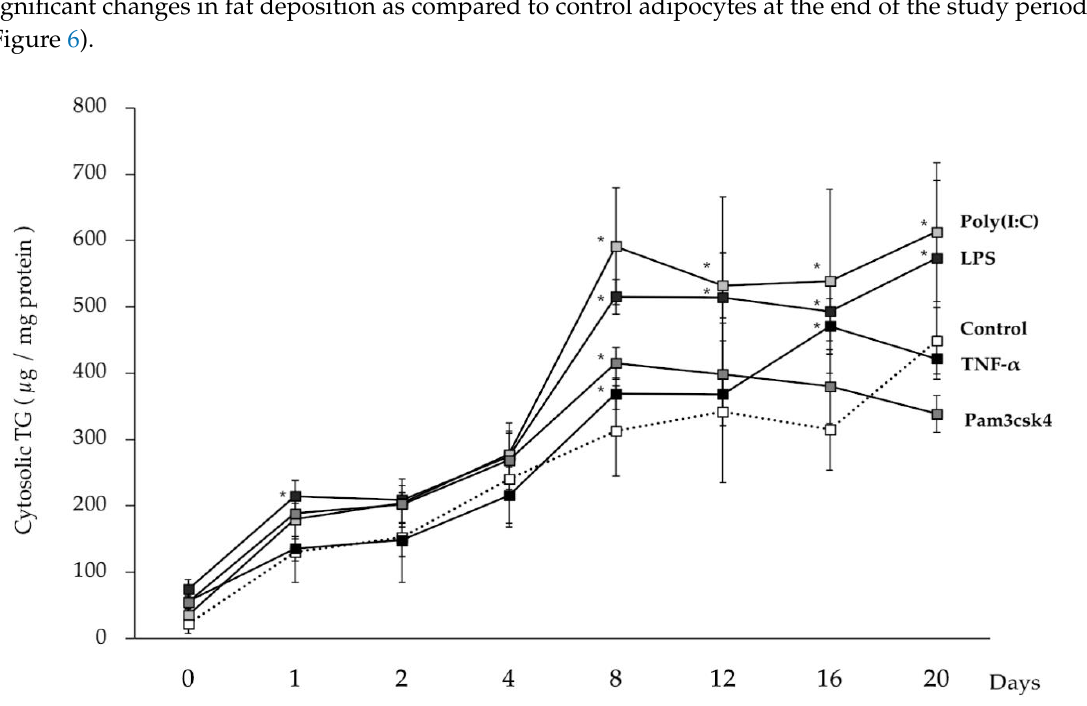
Figure 6. Regulation of fat accumulation in adipocytes by the stimulation of immune receptors. Adipocytes were stimulated either by TNF- α (2.5 ng / mL) or Pam3csk4 (10 ng / mL) or poly(I:C) (0.1 µ g / mL) or LPS (0.1 µ g / mL) for 12 h and kept for 20 days with regular changing culture media. Pam3CSK4, poly(I:C), and LPS represent the ligands for TLR2, TLR3 and TLR4, respectively. Data shown are the average ± SD of 3 independent experiments performed in triplicates. The asterisk (*) indicated the statistical difference between each treated group cells and the untreated control of corresponding time points, at the significance levels of p < 0.05.